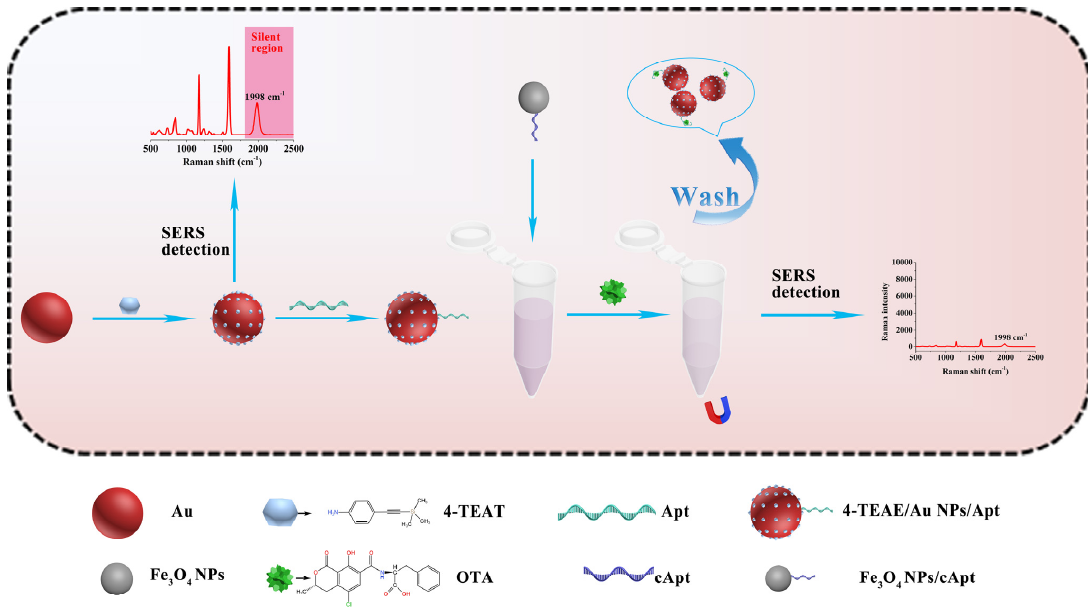
Figure 1. Schematic representation of the principle for the alkyne-mediated SERS aptasensor for anti-interference Ochratoxin A detection.